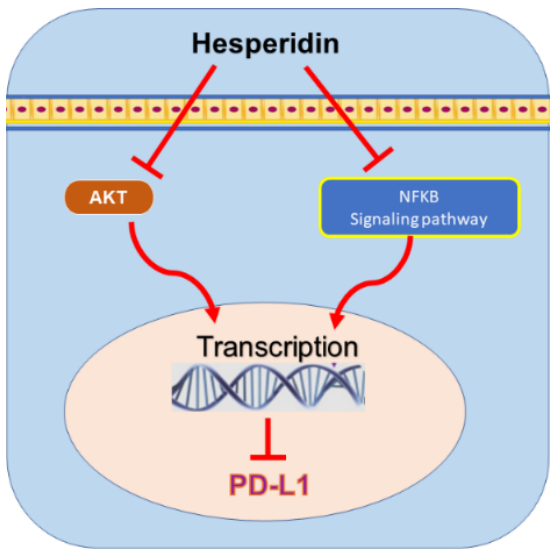
Figure 5. The mechanisms of hesperidin-mediated programmed death-ligand 1 (PD-L1) inhibition in breast cancer cells. Protein kinase B, AKT; nuclear factor-kappa B, NF- ƙ B.